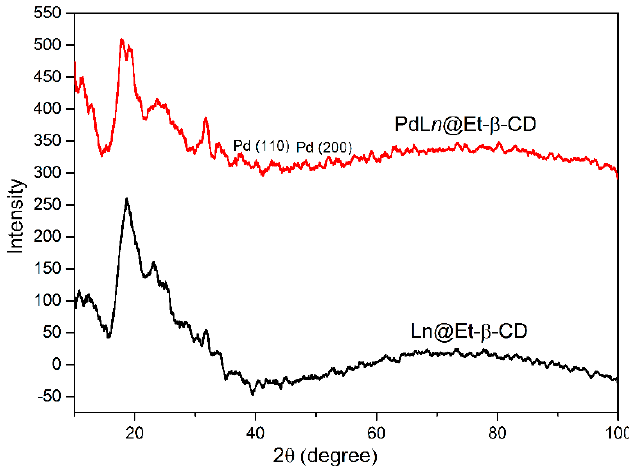
Figure 3. XRD patterns of Et ‐β‐ CD and PdLn@Et ‐β‐ CD.